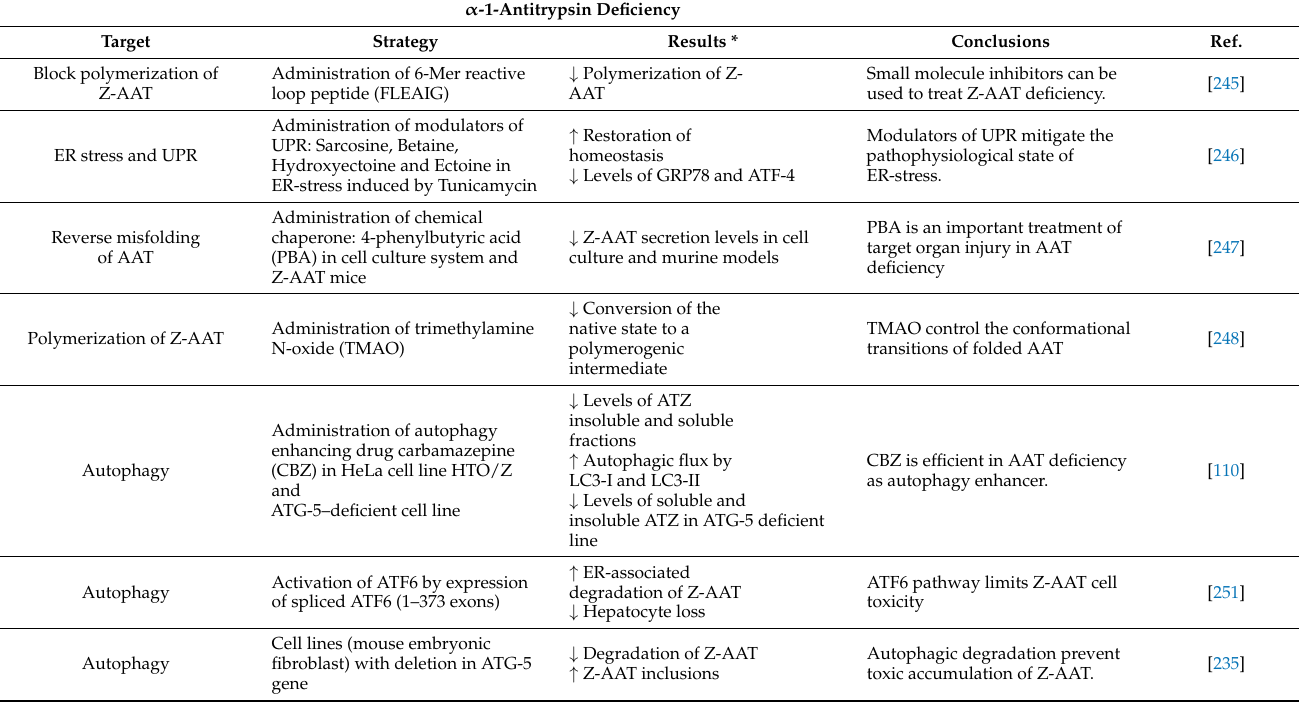
Table 3. Targets for clinical strategies against AAT in